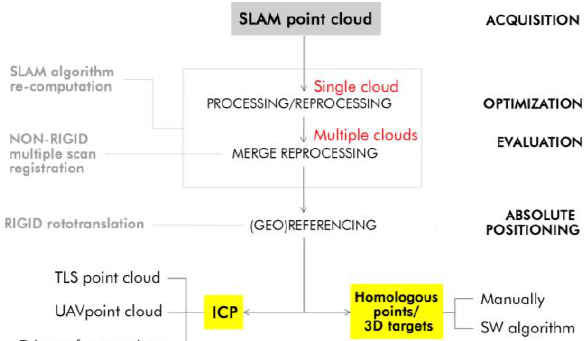
Figure 6. The workflow for ZEB data processing, evaluation, optimization and positioning